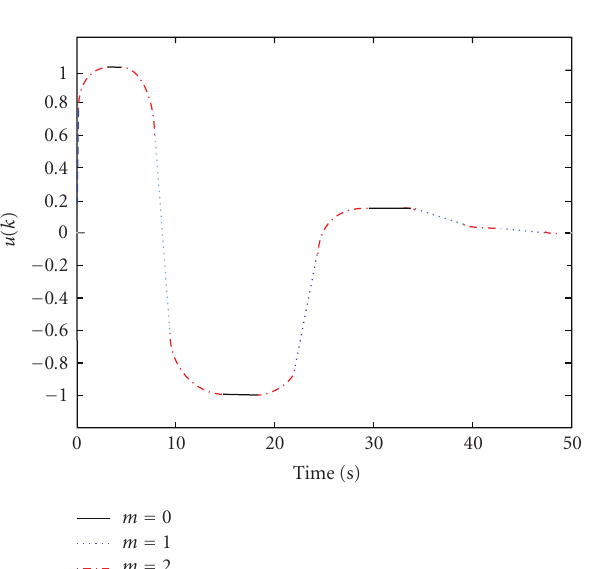
Figure 7: Closed-loop response.